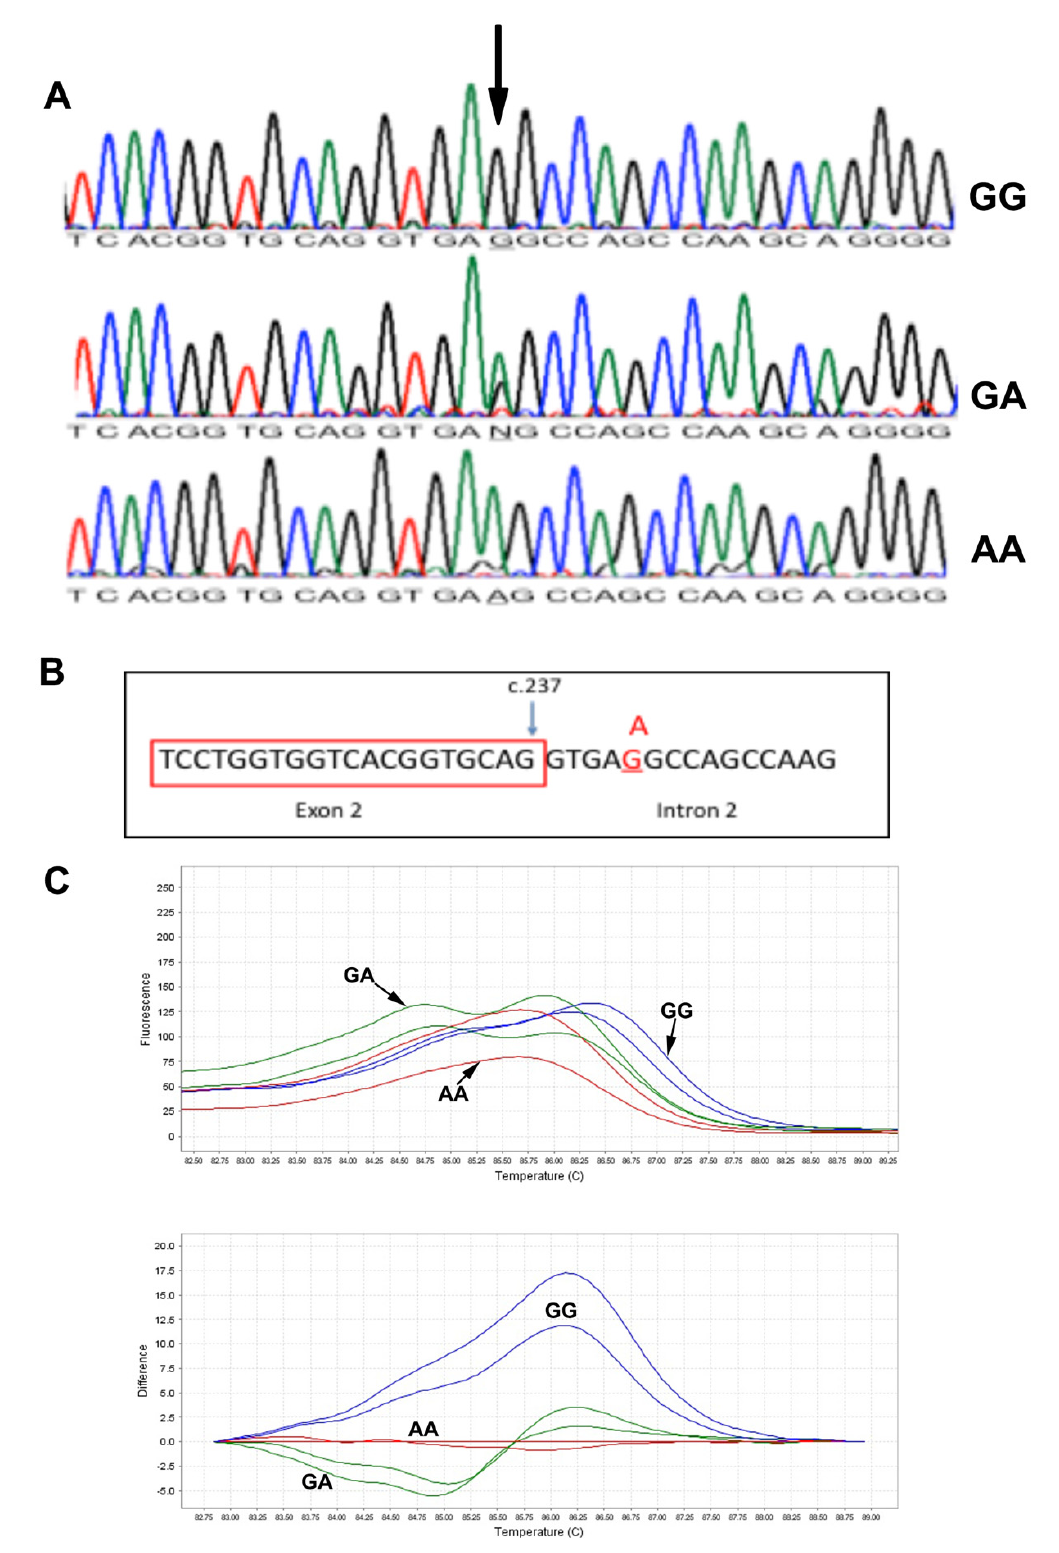
Figure 3. Molecular analysis of the MCOLN1 c.237+5G>A mutation. ( A ): DNA Sanger sequencing results in subjects with GG, GA and AA genotypes. ( B ): Schematic presentation of the c.237+5G>A mutation at the junction of exon 2 and intron 2. ( C ): High ‐ resolution melting results: melting derivative plot (upper) and difference plot (lower). GG: blue line, GA: green lines, AA: red lines.